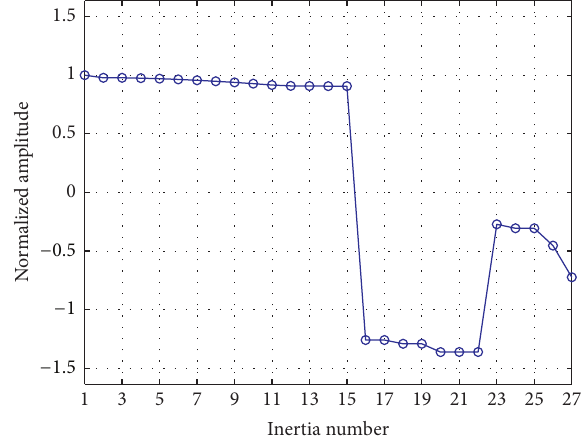
Figure 4: First-order vibration mode.